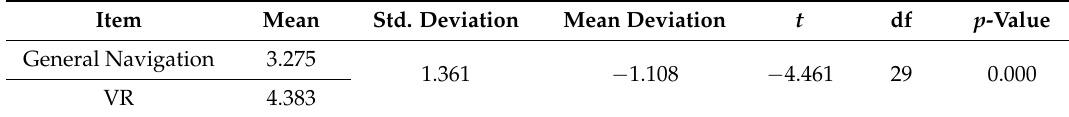
Table 5. Hypothesis test of users’ intention to